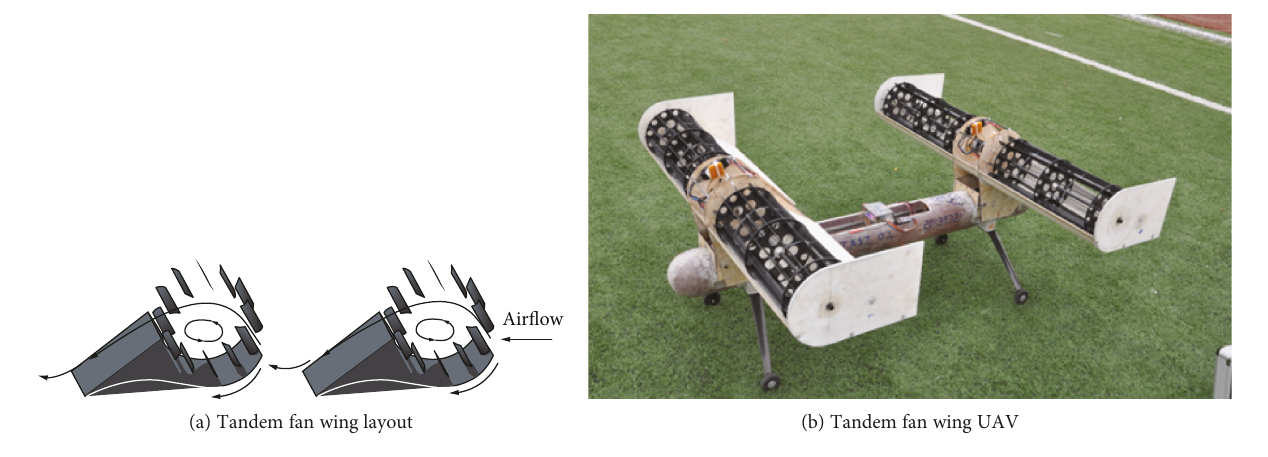
Figure 1: Tandem fan wing.